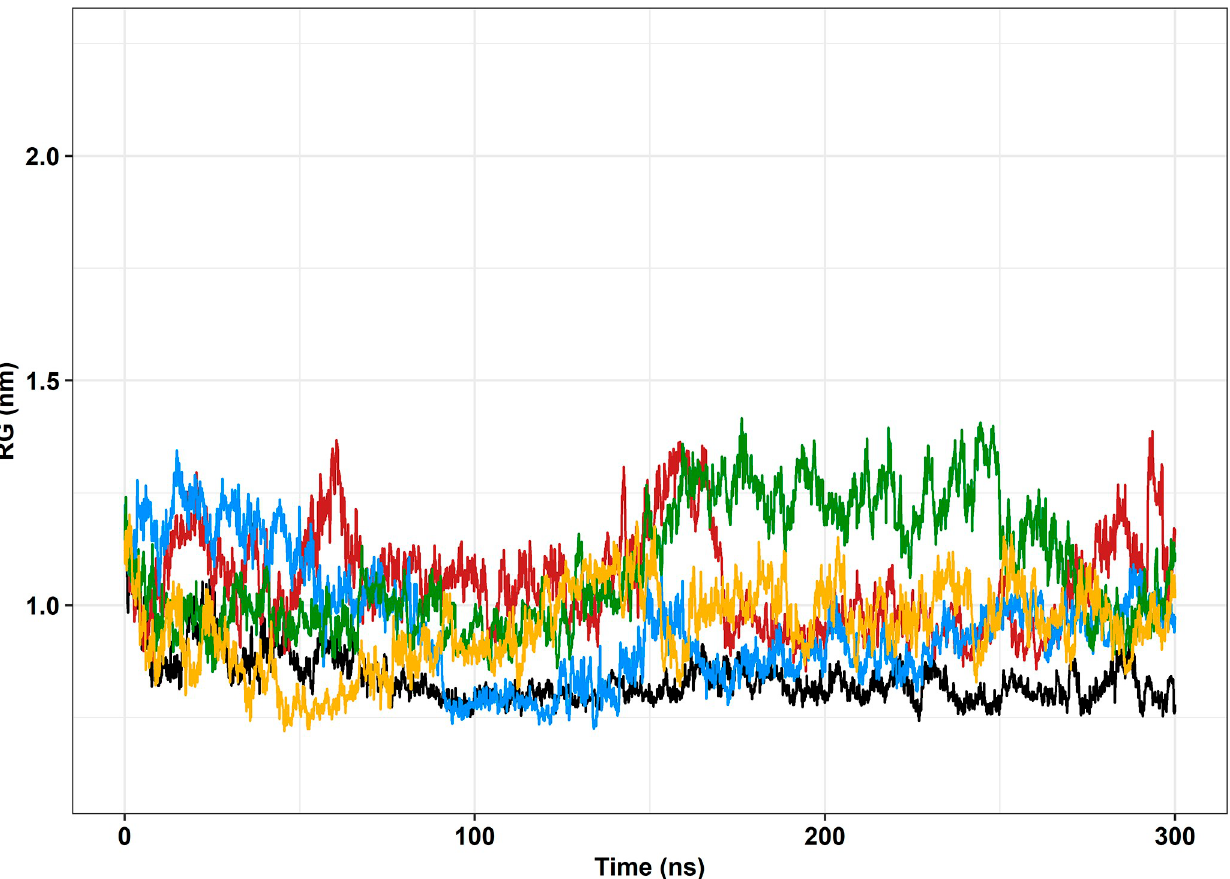
Fig 6. Radius of gyration (RG) of the backbone atoms of the protein as a function of time. The wild-type FUS protein is represented in black, variant R521C is represented in blue, variant 521H is represented in green, variant P525L is represented in red, and variant P525L-PDB [ID: 7CYL] is represented in